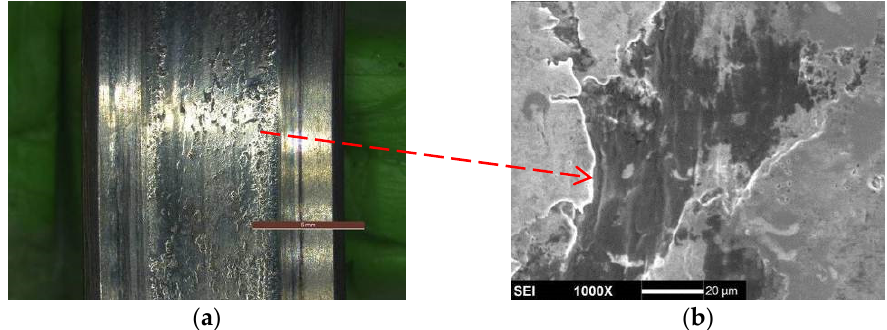
Figure 5. Wear of the outer ring raceway: ( a ) macroscopic damage; ( b ) microscopic damage.